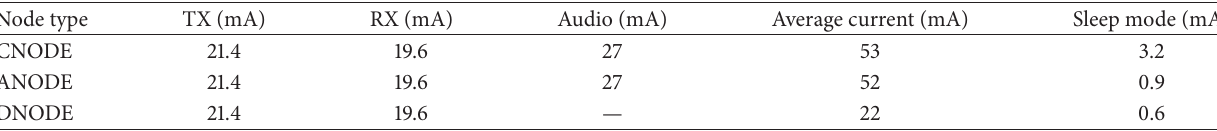
Table 1: Current summary.